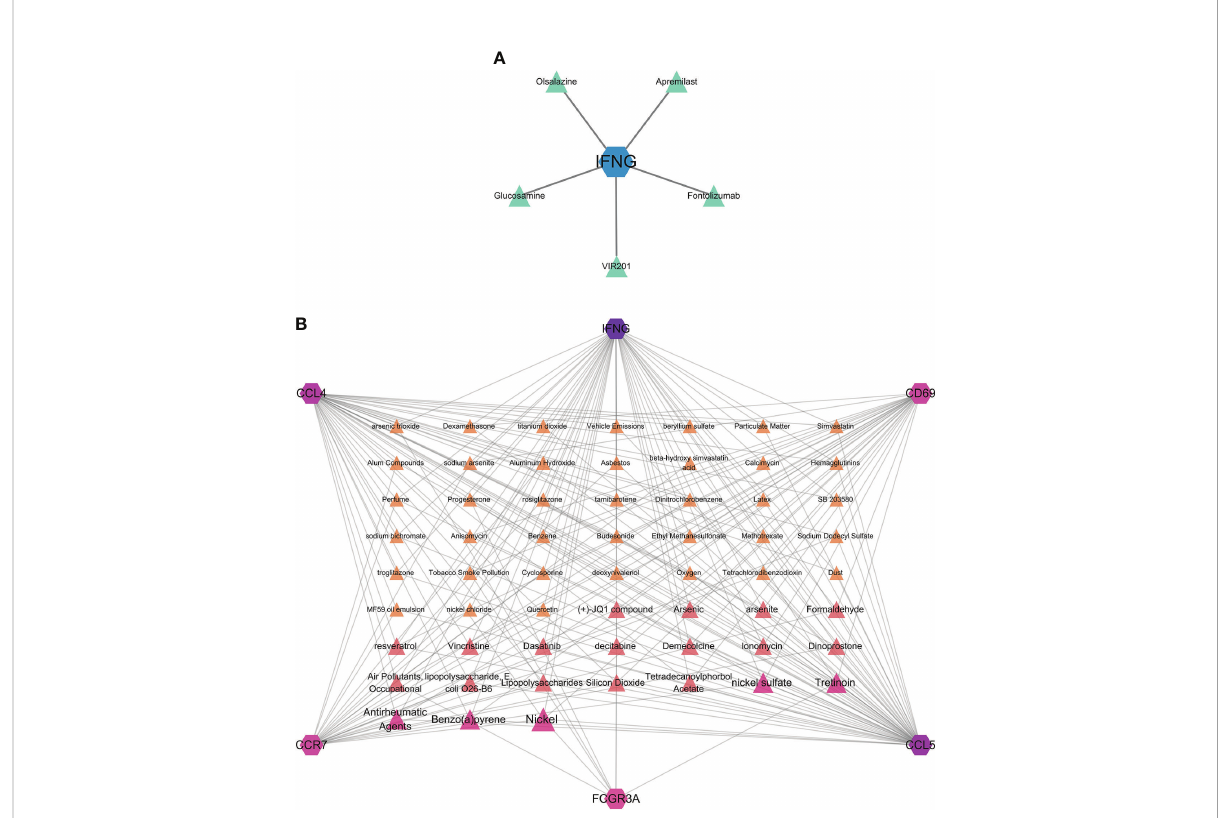
FIGURE 7 Protein – drug and protein – chemical interaction network analyses. (A) Drugs connected to the protein; blue dots indicate the protein, and green dots indicate the drug. (B) Chemicals linked to proteins. The diagram only shows chemicals linked to at least three proteins, with darker colors and larger font sizes indicating linkage to a greater number of proteins.